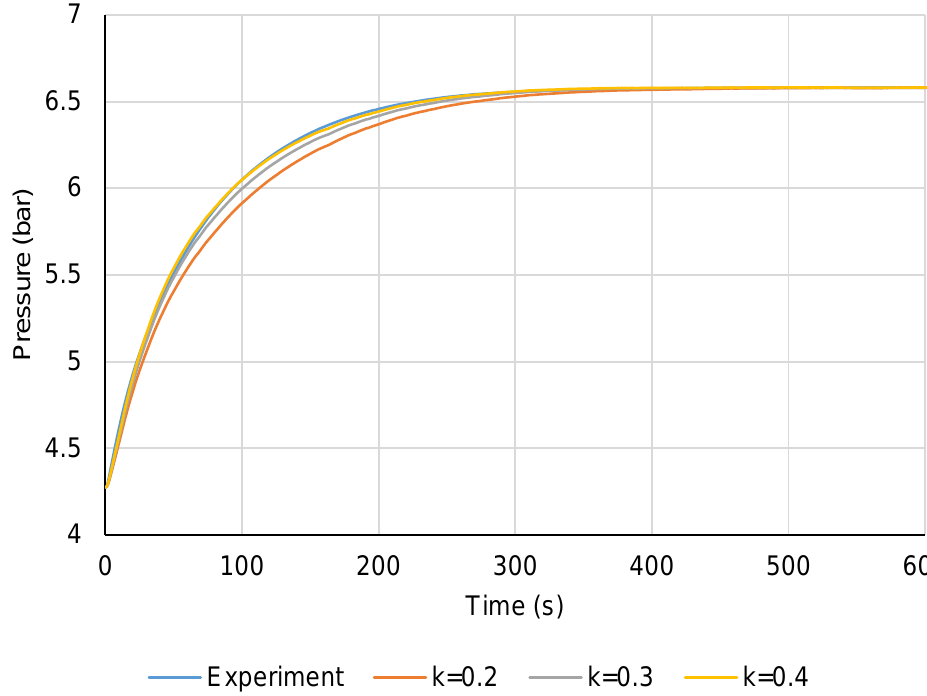
Figure 13. LTJ desorption test pressure change and comparison to model (300-mm module). Running the model with a range of conductivity values between 0.3 and 0.4 W m − 1 K − 1